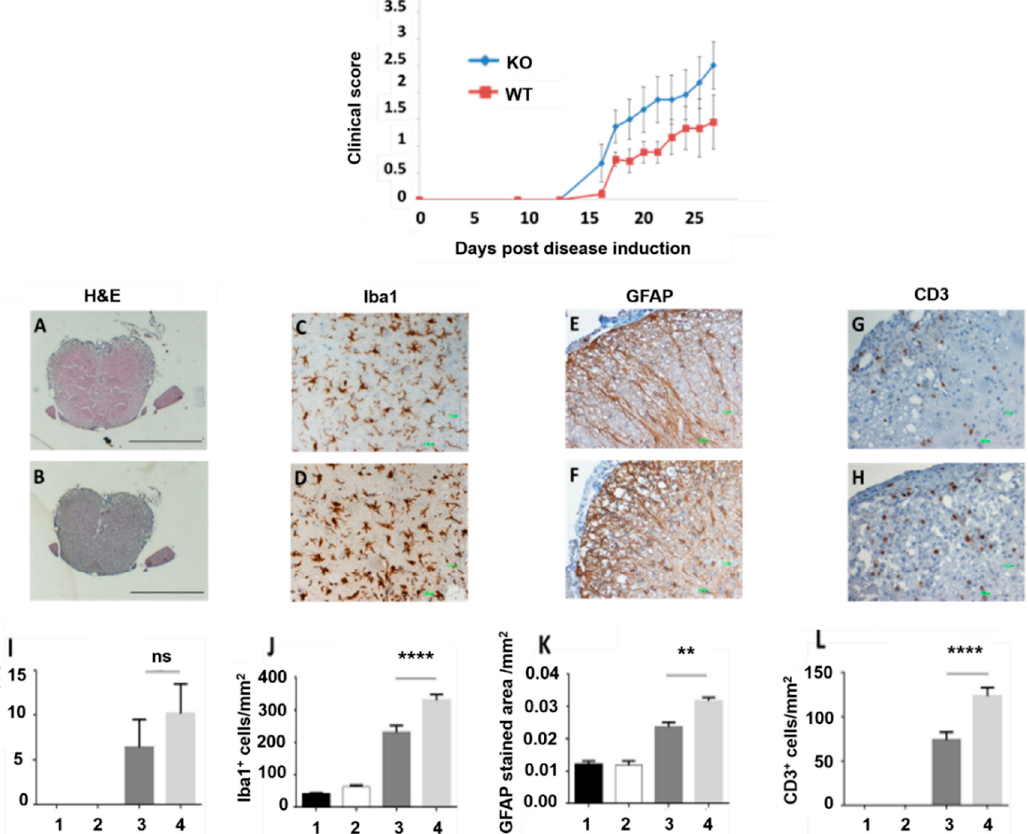
Figure 5. APOBEC-1 KO mice present higher severity EAE, as assessed by clinical disease score and underlying histopathological aspects, compared to wild-type animal (WT)s. Top panel: Mean clinical scores from active EAE with MOG 35 − 55 in APOBEC-1 KO and wild-type C57BL/6 mice. Clinical scores were assessed daily, beginning on day 7 and ending on day 21 (acute disease stage). Error bars represent means ± SEM (p< 0.001, two-tailed t -test). Low panel: Histochemical analysis of spinal cord sections from MOG 35–55 -immunized mice. ( A , B ) H&E (bars represent 1000 um), ( C , D ) Iba1, ( E , F ) GFAP, and ( G , H ) CD3 (bars represent 100 um) staining of WT and APOBEC-1 KO EAE mice. ( I ) Quantification of the percent area of inflammation, based on hematoxylin eosin-stained spinal cord sections of naïve and EAE, WT, and APOBEC-1 KO mice. ( J , K , L ) Quantification of Iba1 + -stained cells/mm2, GFAP + -stained area/mm2, CD3 + -stained cells/mm2, respectively, on spinal cord sections of naïve and EAE, WT, and APOBEC-1 KO mice. All samples were collected 21 days post-induction. Error bars represent means ± SEM (**** p < 0.0001, ** p < 0.01, ns = non-significant, Kruskal–Wallis test). 1: wild-type naïve group ( n = 5), 2: APOBEC-1 KO naïve group ( n = 5), 3: wild-type acute EAE group ( n = 9), 4: APOBEC-1 KO acute EAE group ( n = 11).